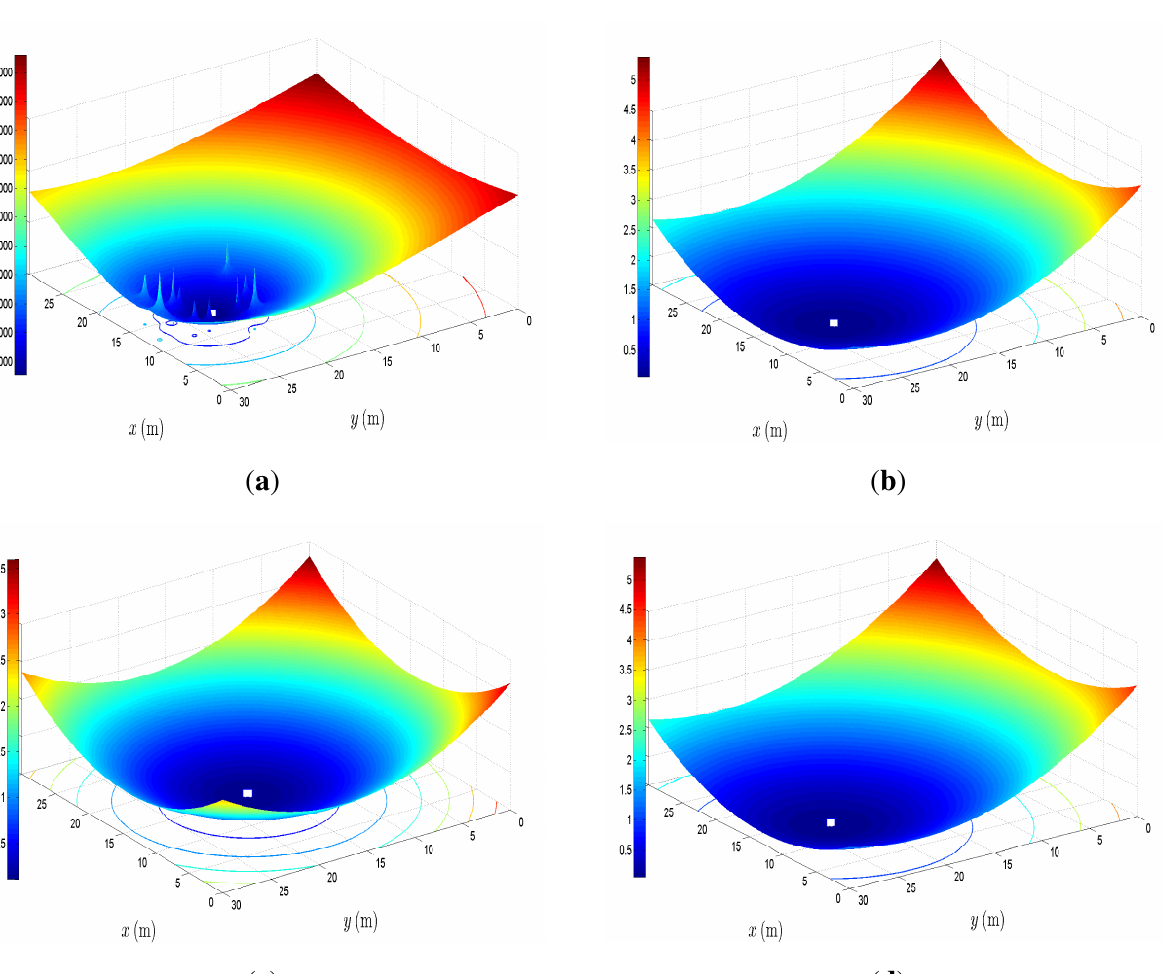
Illustration of the cost functions (4) and (7) versus x and y coordinates (target location); the minimum of the cost function is indicated by a white square. ( a ) Objective function in Equation (4) using the true target positions; ( b ) objective function in Equation (7) using the true target positions; ( c ) objective function in Equation (7) after one iteration; ( d ) objective function in Equation (7) after ten